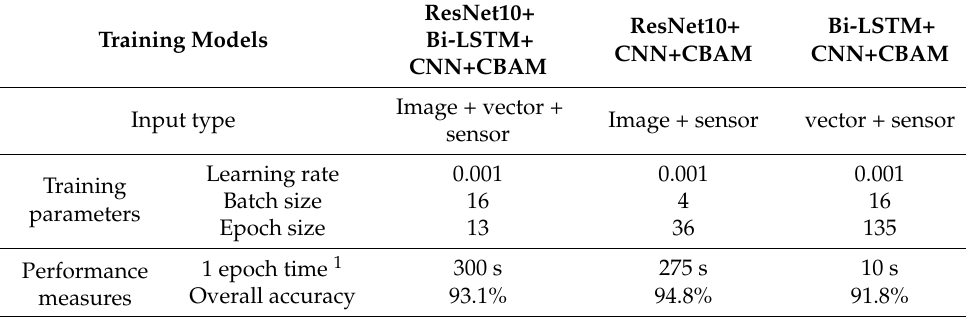
Table 1. Hyperparameters of deep learning